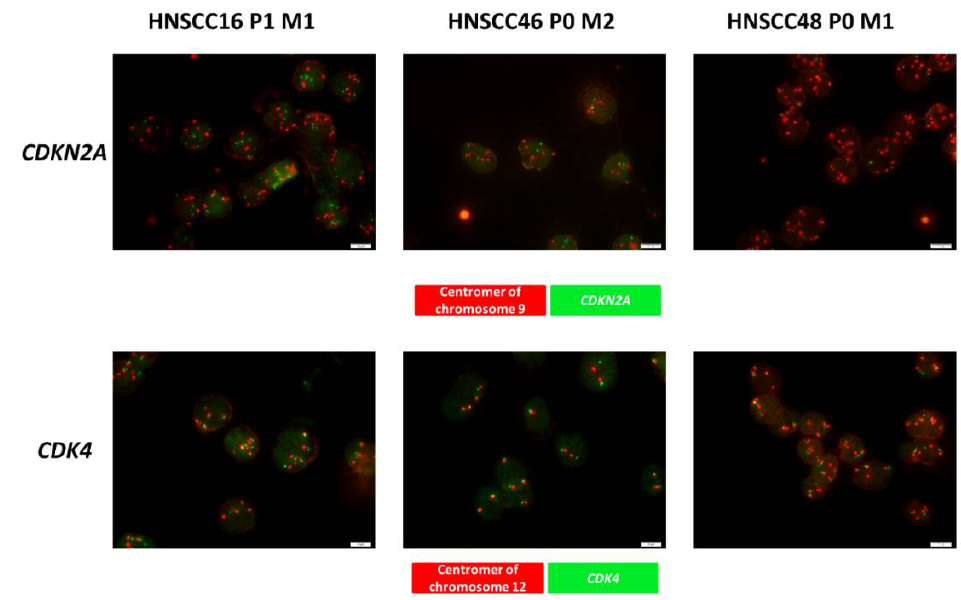
Figure 2. Cyto-FISH for CDKN2a and CDK4 . Cytospins of HNSCC cell lines were stained with the SPEC CDK4/CEN 12 Dual Color Probe or SPEC CDKN2A /CEN9 Dual Color Probe to check for gene specific amplification of CDKN2A and CDK4 . The red spots indicate the centromers and the green spots indicate the specific gene. A readout was carried out with the fluorescence microscope Olympus BX53. Original magnification 1000 ×